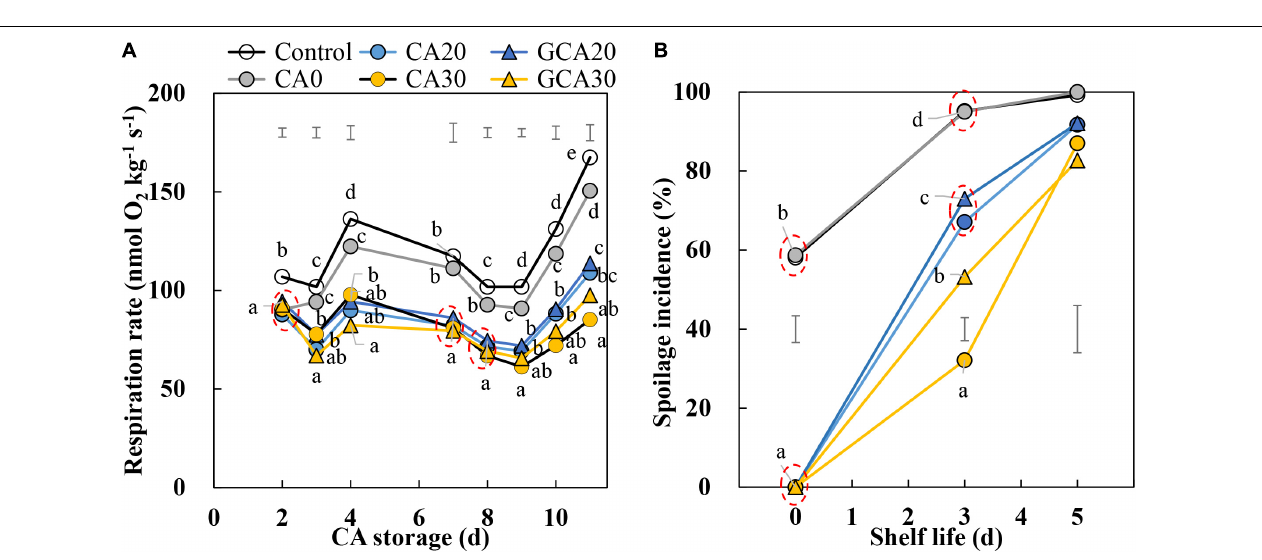
FIGURE 1 | Spoilage incidence of “Sonsation” strawberry fruit stored under static controlled atmosphere (CA) conditions and shelf life. (A) Spoilage incidence at different time points during CA storage at 5 ◦ C and ∼ 100% relative humidity. (B) Spoilage incidence at different time points of CA storage followed by 3-day shelf life at 12 ◦ C and ∼ 95% relative humidity in ambient atmosphere. The first number is the number of days in CA storage, and the second number is the number of days in shelf life. As a control condition, 21 kPa O 2 and 0 kPa CO 2 were used. Data represent means of 3 blocks ( n = 3) with five replicated fruit per block. The error bars represent the standard error of means. Different letters denote significant differences according to Fisher’s protected LSD test ( α = 0.05).